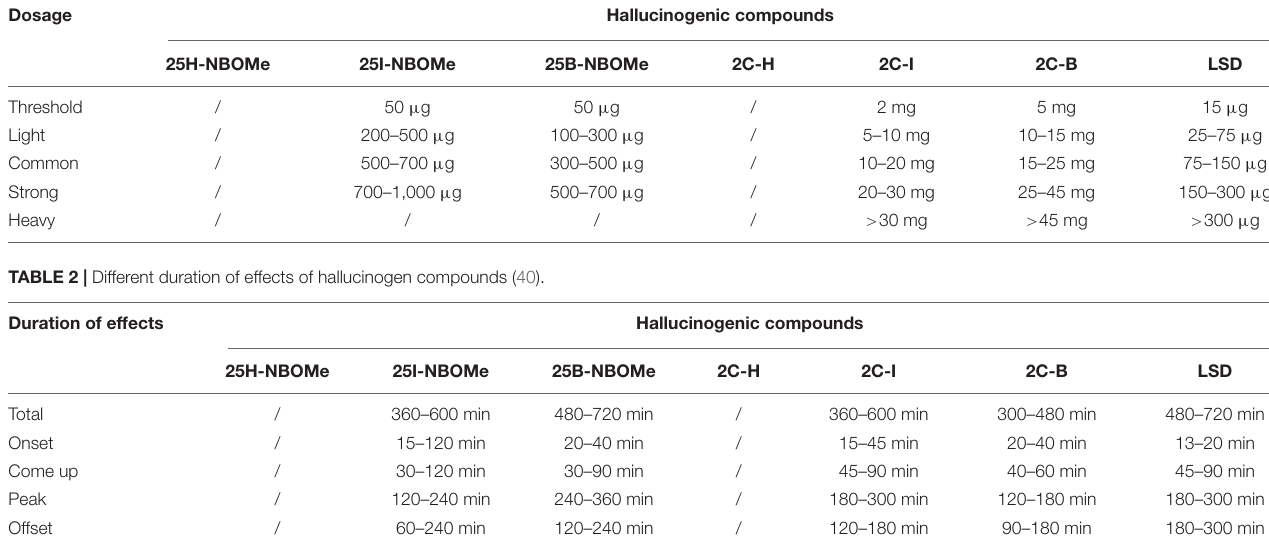
TABLE 1 | Different dosages of hallucinogenic compounds (40).